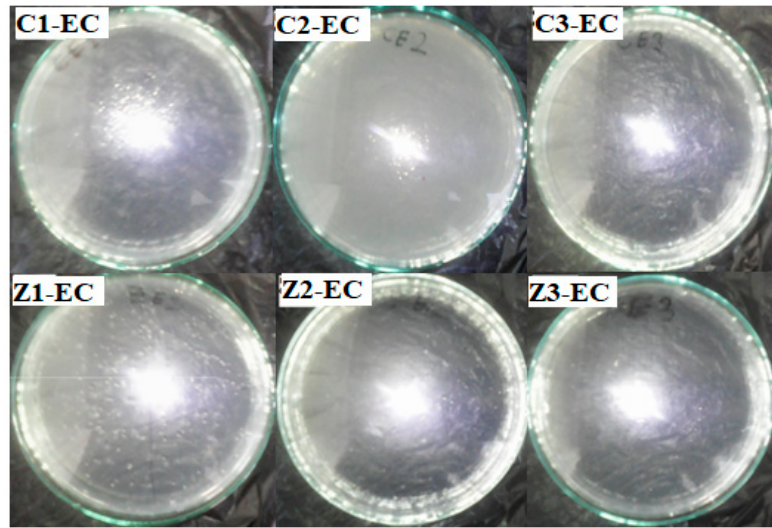
Figure 25. Antibacteria activity of clay/CuO/Ag and clay/ZnO/Ag against E. coli in water after 48 h of incubation. C1-EC, C2-EC, C3-EC correspondingly relates to clay/CuO/Ag-1, clay/CuO/Ag-2 and clay/CuO/Ag-3 E. coli. Z1-EC, Z2-EC, Z3-EC correspondingly relates to clay/ZnO/Ag-1, clay/ZnO/Ag-2 and clay/ZnO/Ag-3 against E. coli .